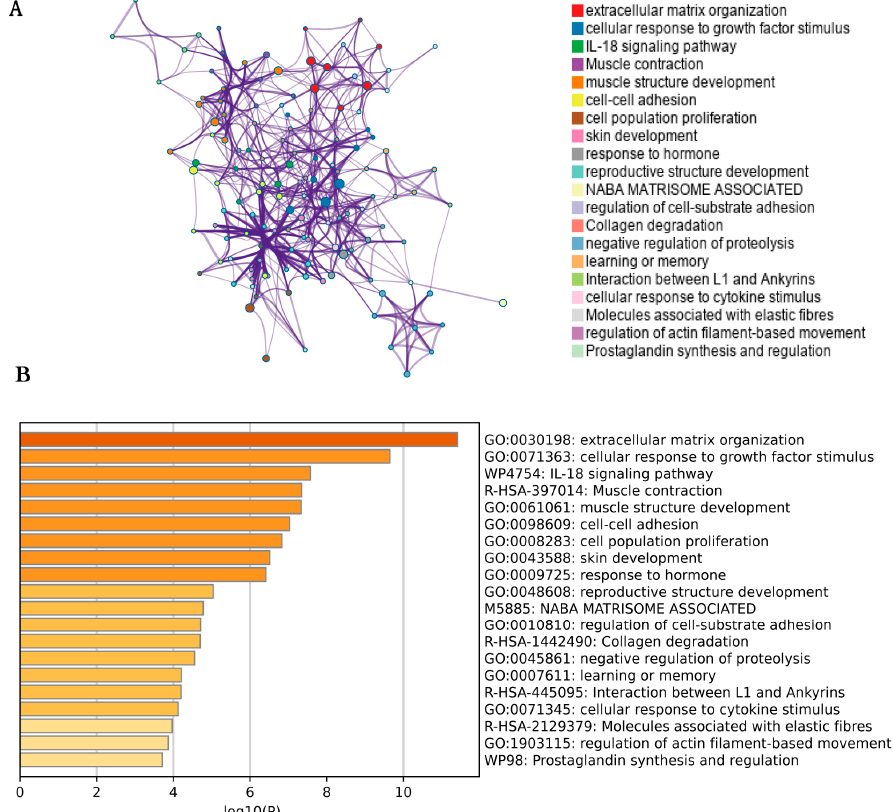
Figure 3. ( A ) The enrichment pathway is also presented as a network. A unique color represents each set of host factors. ( B ) The horizontal coordinate is a logarithmic value of p values with a base of 10 and negative values; the vertical is the different enrichment pathways that have been sorted by the value of − log10(P). The larger the − log10(P) value ranked above, the smaller the p values and the more significant the enrichment (and the darker the color).